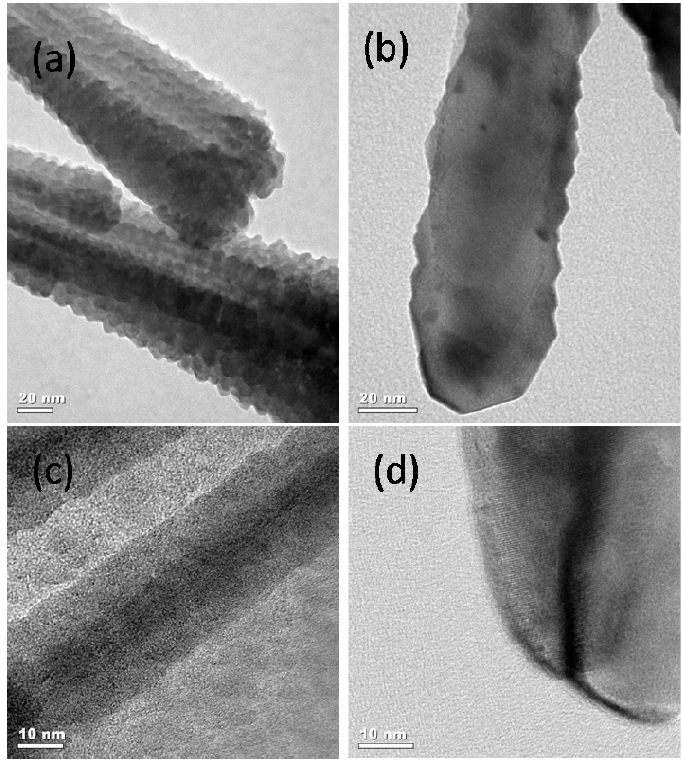
Figure 12. TEM images of the synthesized TiO annealing; ( c ) and ( d ) after annealing at 800 °C for 3